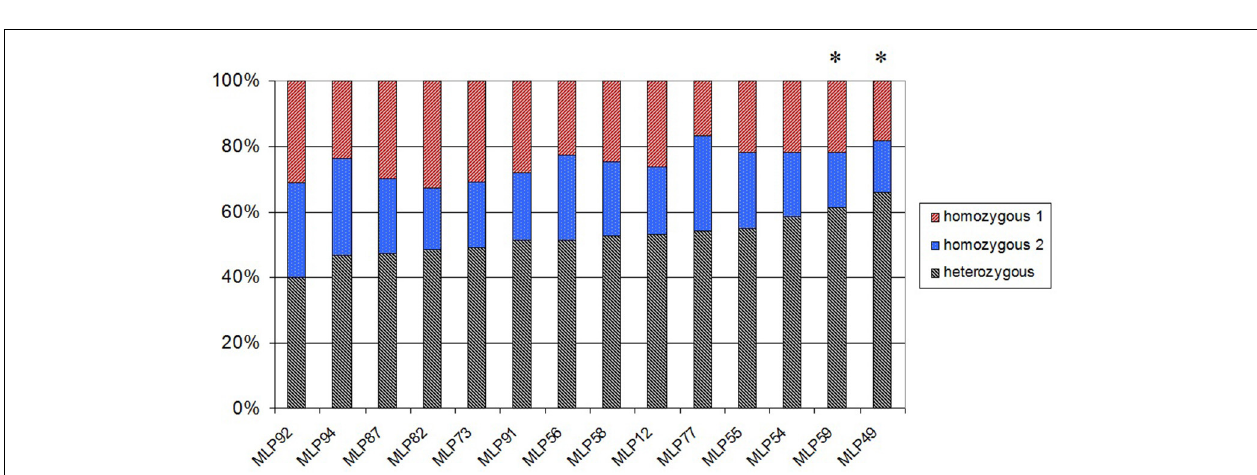
FIGURE 1 | Successive stages of the life cycle observed in the production of the M. larici-populina S1 progeny. (A) Inoculated poplar leaf covered with uredinia on the abaxial surface (scale bar 1cm). (B) Light brown to dark brown telia forming on the adaxial surface of a poplar leaf (scale bar 1mm). (C) Black mature telia obtained at leaf fall (scale bar 5mm). (D) Outdoor overwintering of